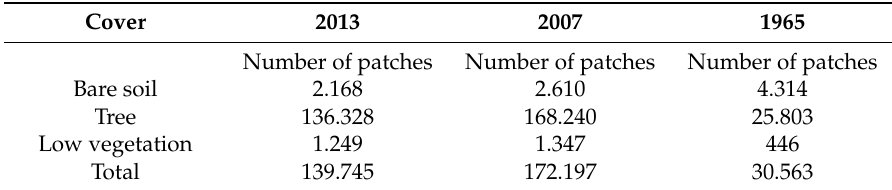
Table 8. Number of patches (NP) for the different years.